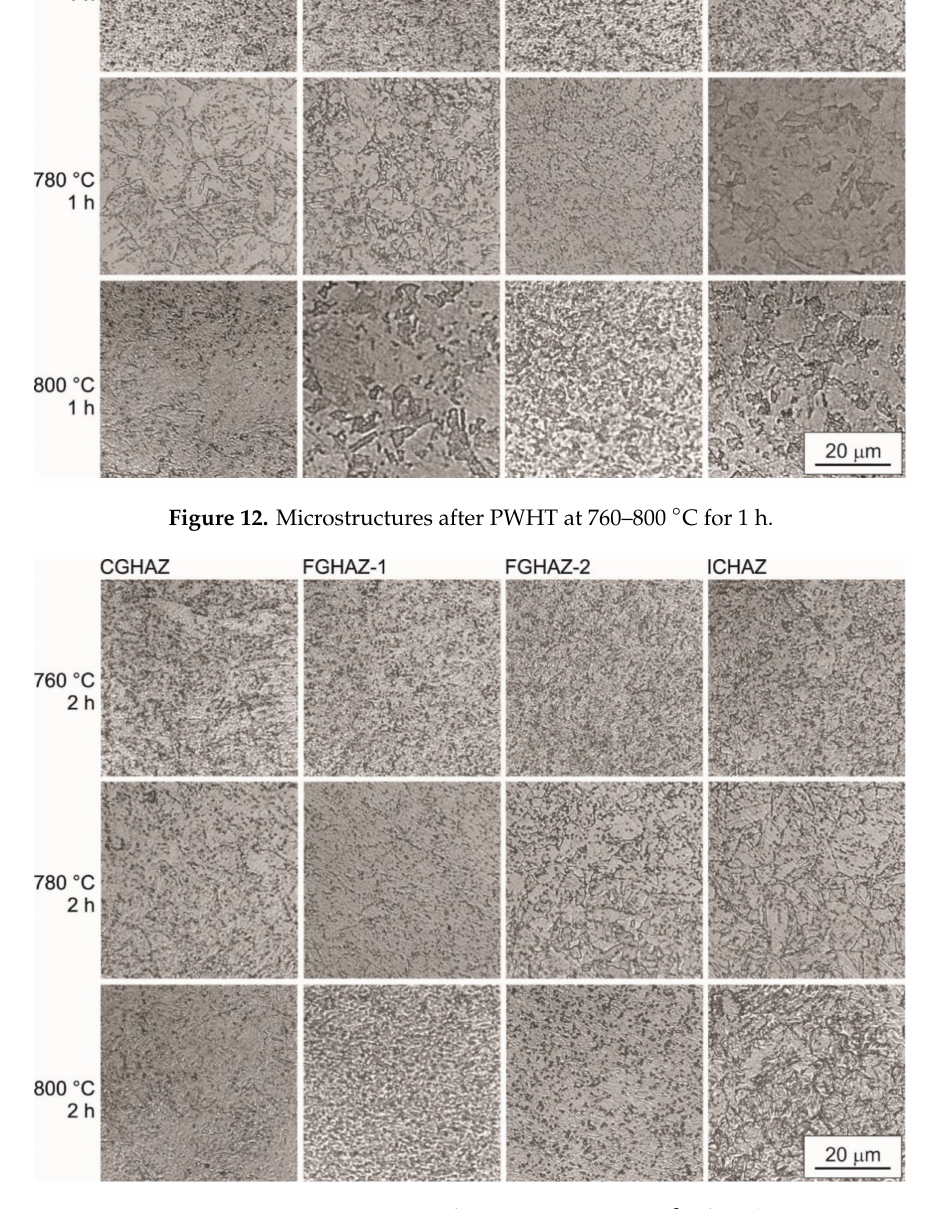
Figure 13. Microstructures after PWHT at 760–800 ◦ C for 2